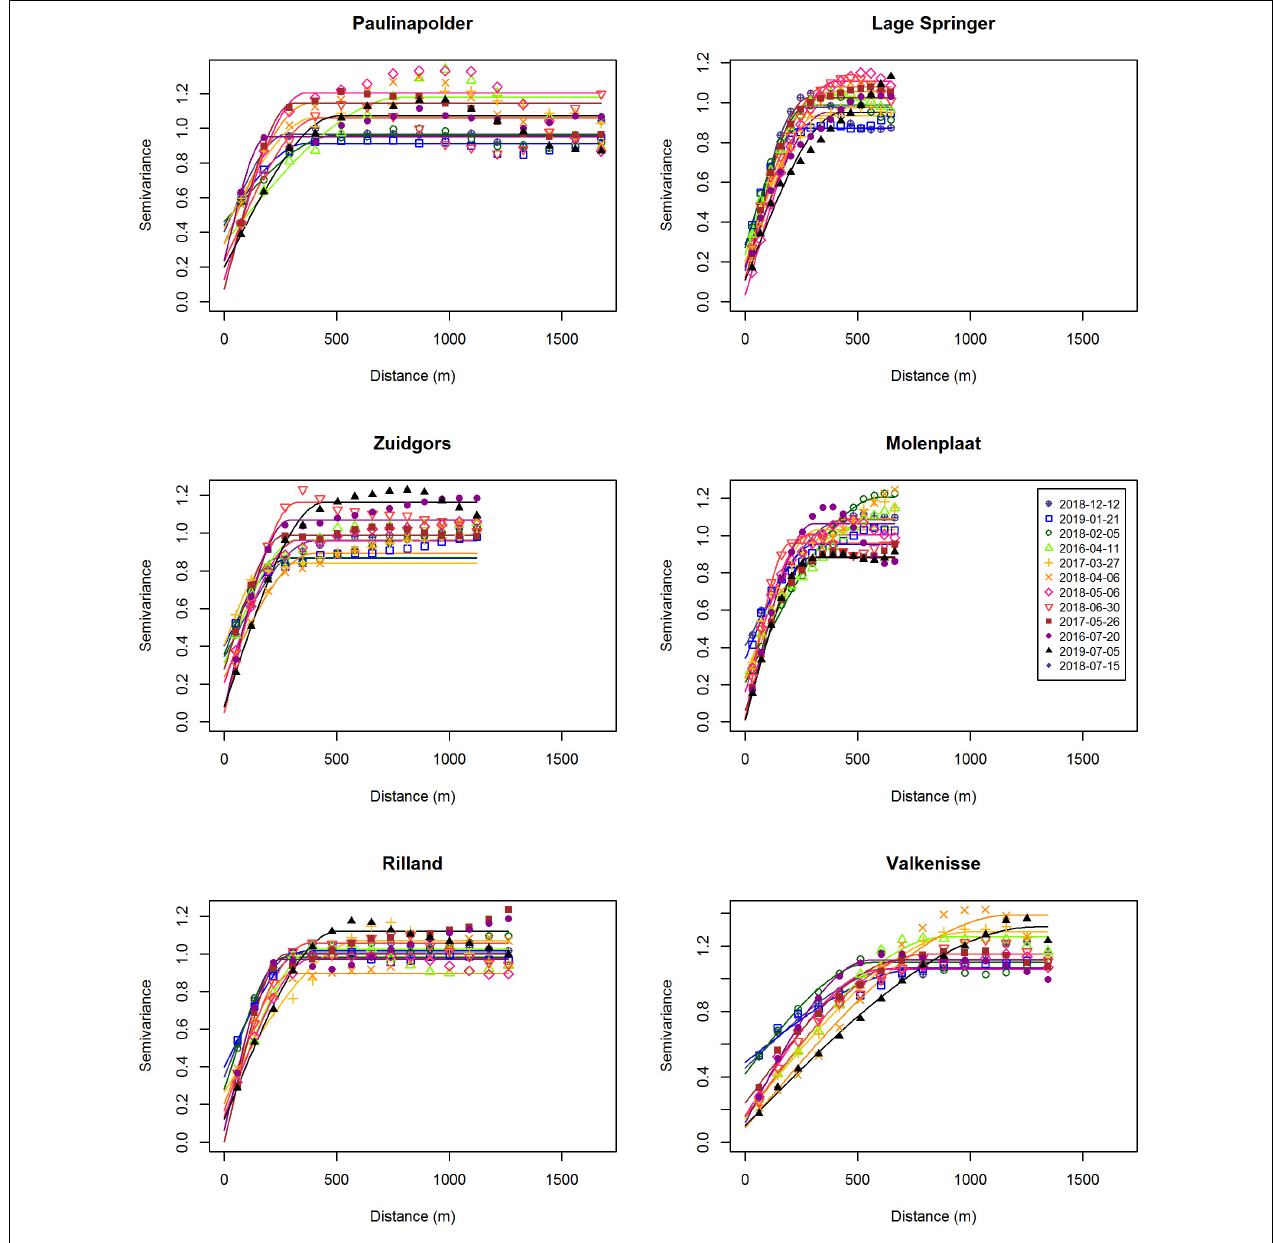
FIGURE 3 | Semi-variograms per